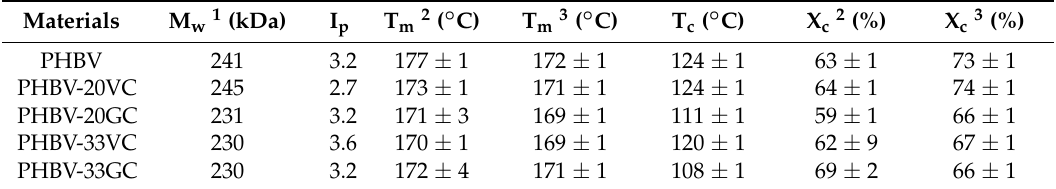
Table 1. Molecular weight (M w ) with polydispersity index (I p ), thermal properties (melting temperature (T m ) and crystallization temperature (T c )), and degree of crystallinity (X c ) of PHBV-based composites.